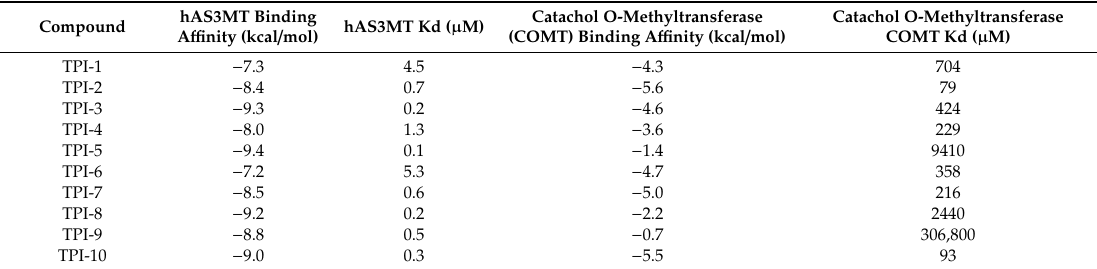
Table 5. Comparison of binding properties of 10 small molecule inhibitors to AS3MT calculated using Autodock Vina33